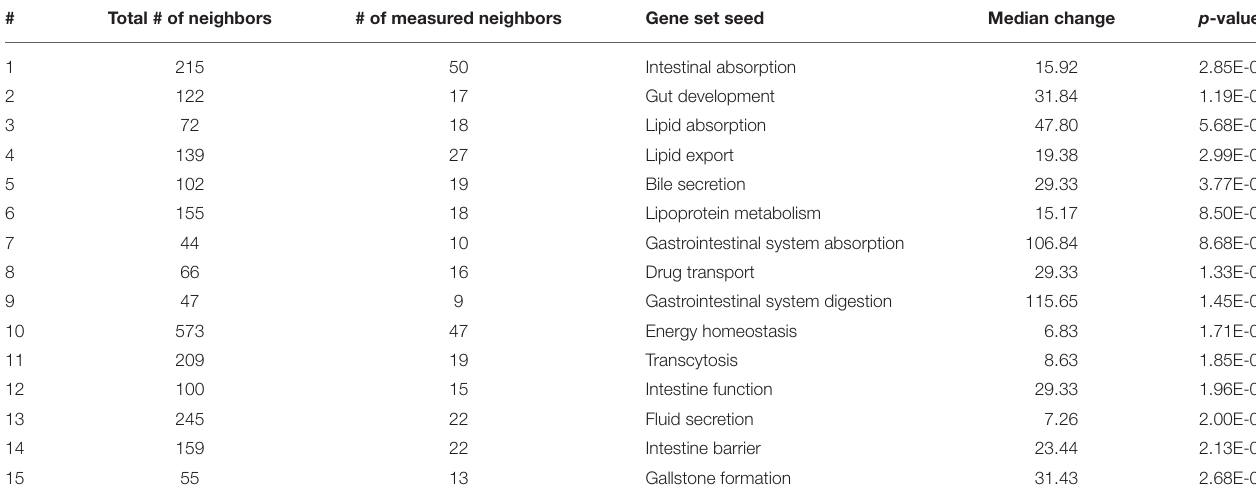
TABLE 2 | Subnetwork enrichment analysis of gene sets specific for the gastrointestinal tract.